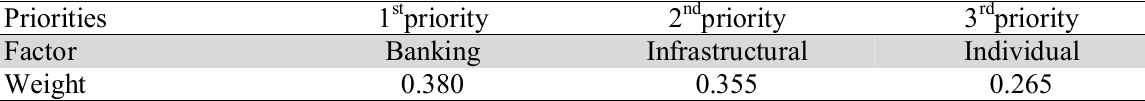
The results of ranking of banking, infrastructure and individual factors